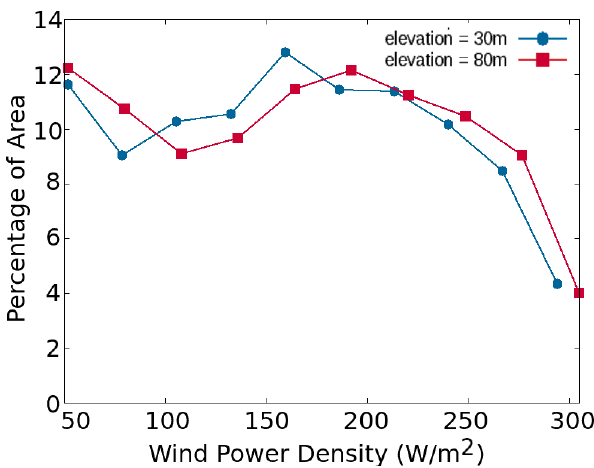
Figure 20. Wind power density at 80 m.